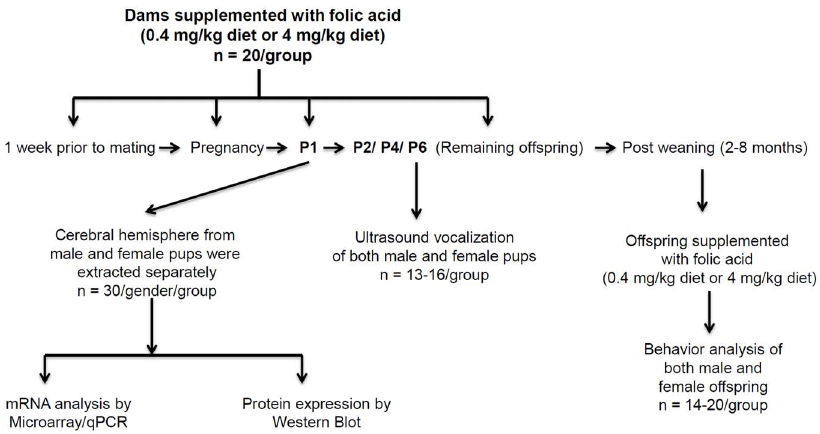
Figure 1. The schematic diagram of the experimental design for this study.